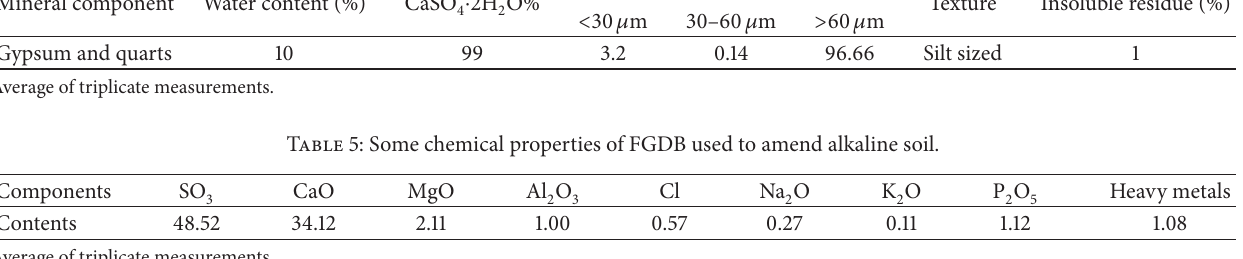
Table 4: Some mineralogical and physical properties of FGDB used to amend alkaline soil. Mineral component